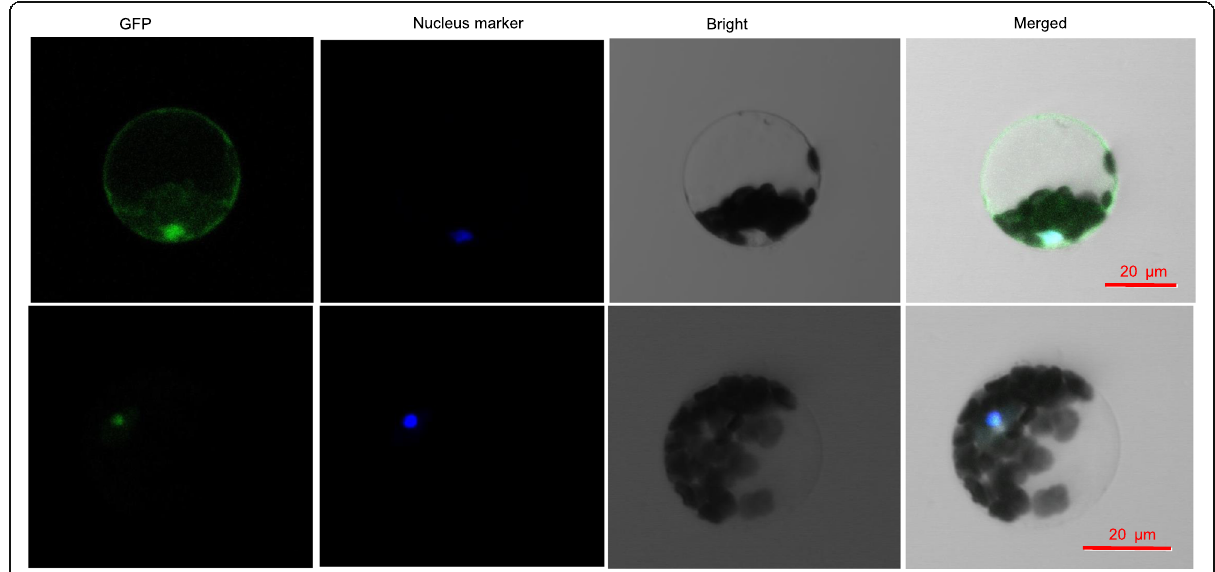
Fig. 4 Subcellular localization of GhREV2 in Arabidopsis protoplasts. GhREV2 localizes in nucleus. GFP or GhREV2-GFP was expressed in Arabidopsis protoplast. Protoplasts were isolated from leaves of 10-day-old Arabidopsis to express 35S::GFP (top) or 35S::GhREV2-GFP (bottom). The subcellular localization were examined using a confocal microscope. Bright is bright field. Bright field and green fluorescence images were merged. Scale bars = 20 μ